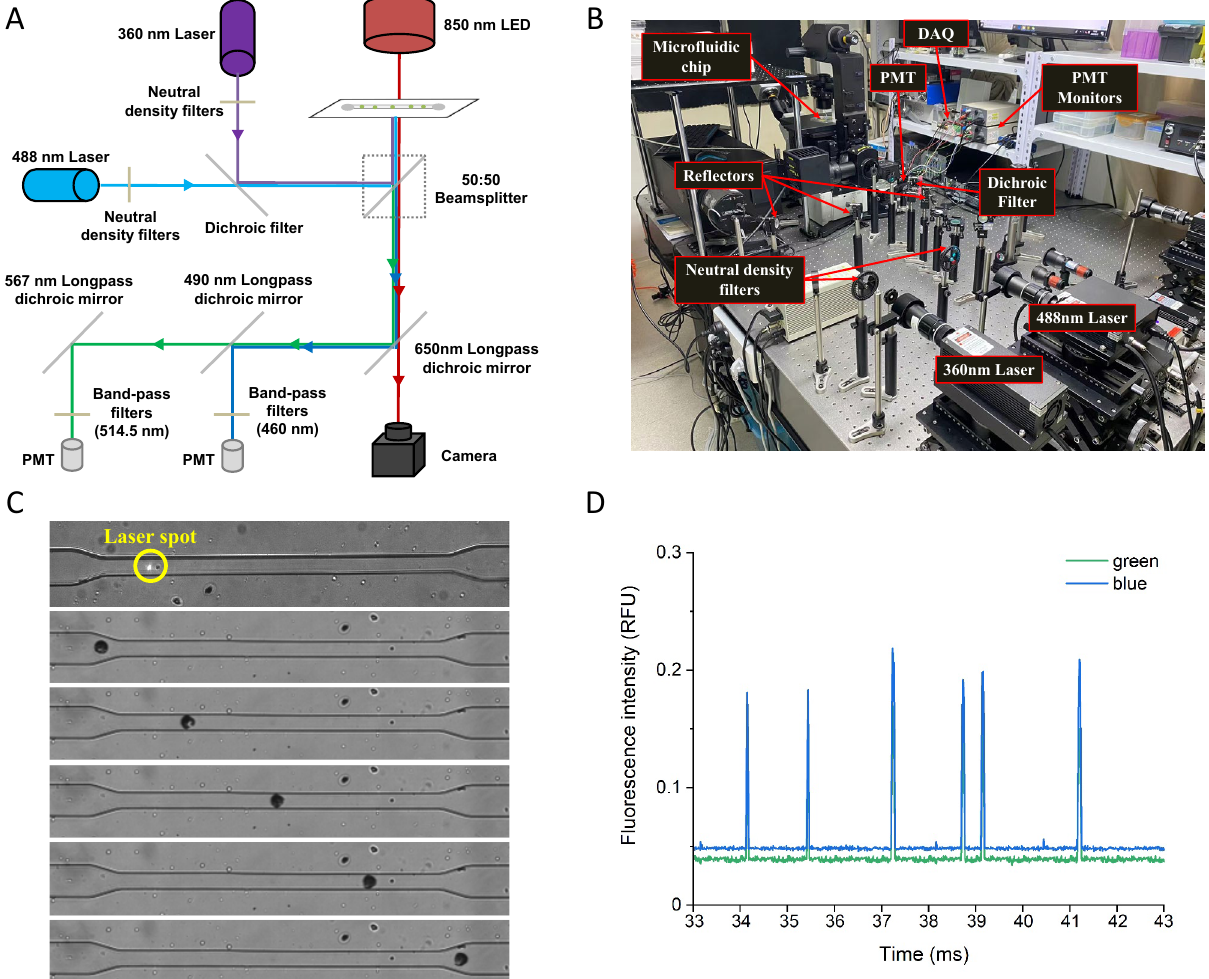
Figure 1. Microfluidic flow cytometry. ( A ) Schematic diagram of the developed platform; ( B ) Photograph of the developed platform; ( C ) Time-lapse images of a single plant cell passing through the channel; ( D ) Real-time response of dual-channel fluorescence detection of a single plant cell.